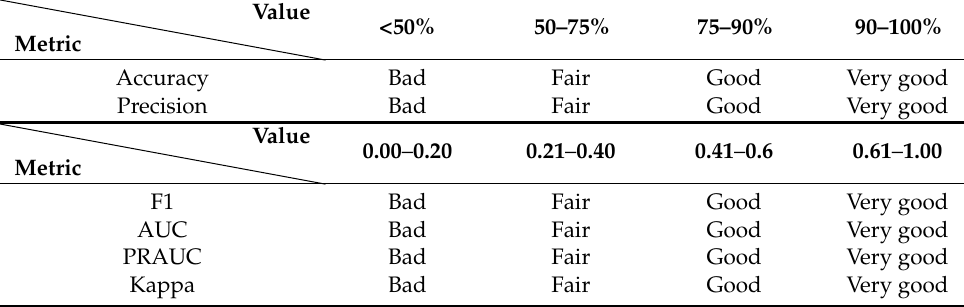
Table A4. Value and classification of the indicated